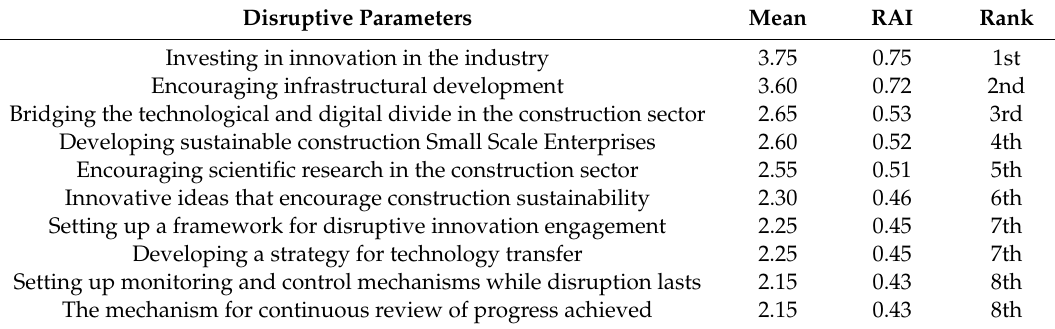
Table 7. Disruptive innovation of Industry 4.0, induced by Construction